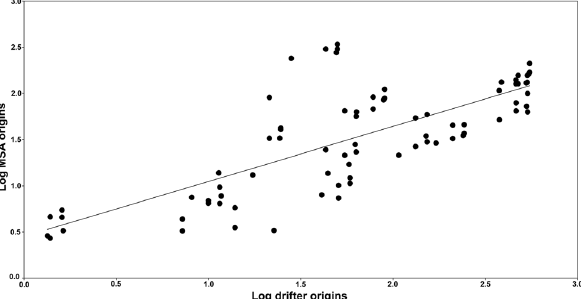
Figure 5. Correlation between genetic and drifter profiles for Brazilian feeding grounds. Genetic profiles are based on log- transformed data of origins from genetic/population size (MSA – x axis) and drifter/population size (y axis) information